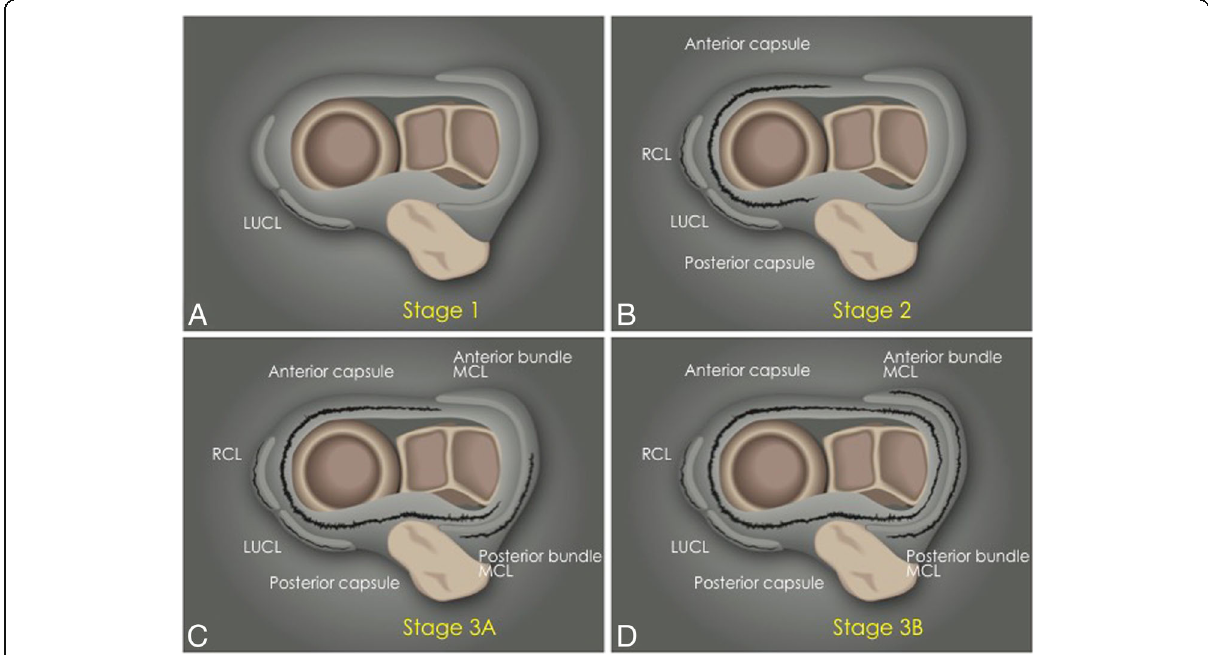
Fig. 21 Axial illustrations with superior view demonstrating the progression of the structures injured in the posterolateral rotatory